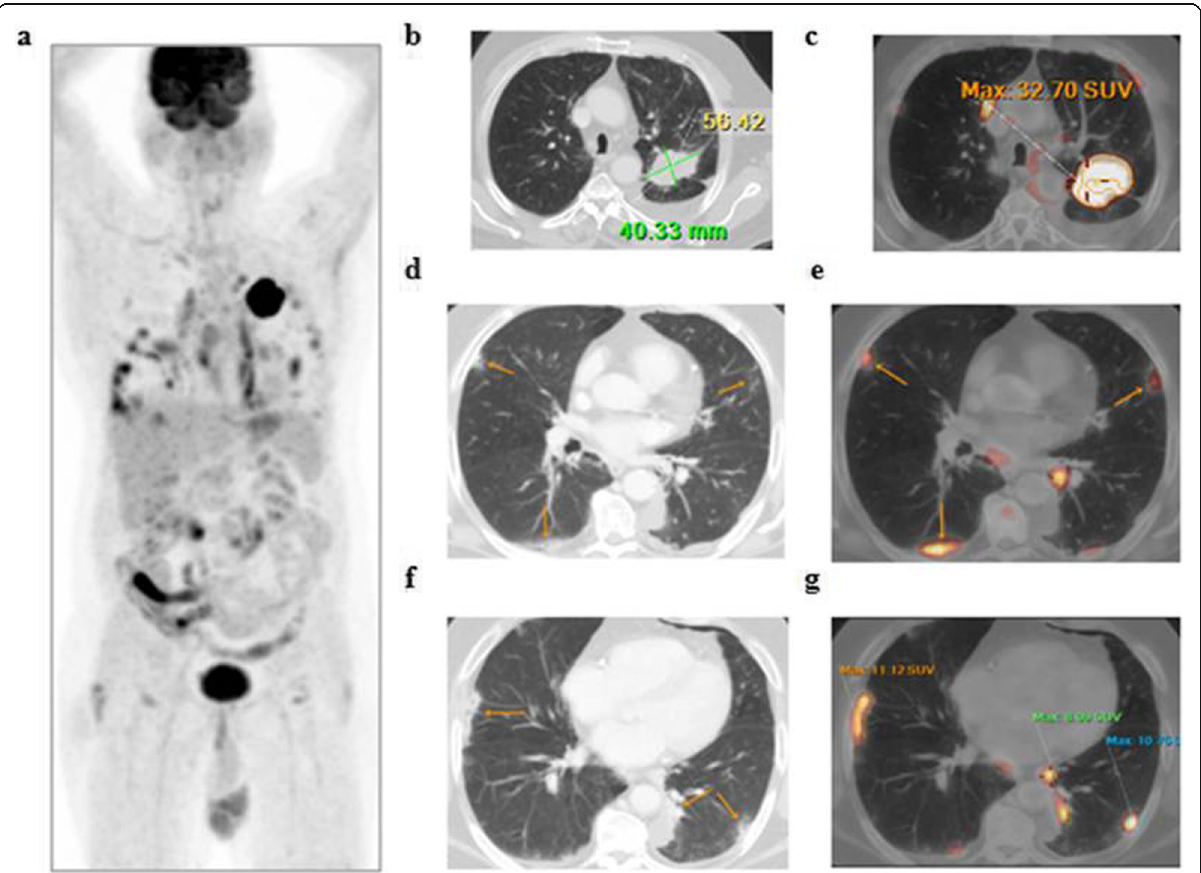
Fig. 1 A 55-year-old male patient, presented with recently diagnosed left lung cancer and referred for initial PET/CT evaluation. a The whole- body MIP image shows an FDG avid upper left lung lesion with other multiple bilateral pulmonary metabolically active areas. Axial lung window CT ( b ) and corresponding fused PET/CT ( c ) images revealed an FDG avid left lung upper lobar speculated primary neoplastic mass (achieving 32.7 SUVmax), while axial CT images ( d , f ) revealed multiple bilateral subpleural variable-sized ground-glass opacities and patchy consolidation that show variable FDG avidity in corresponding fused PET/CT images ( e, g ) achieving up to 11.5